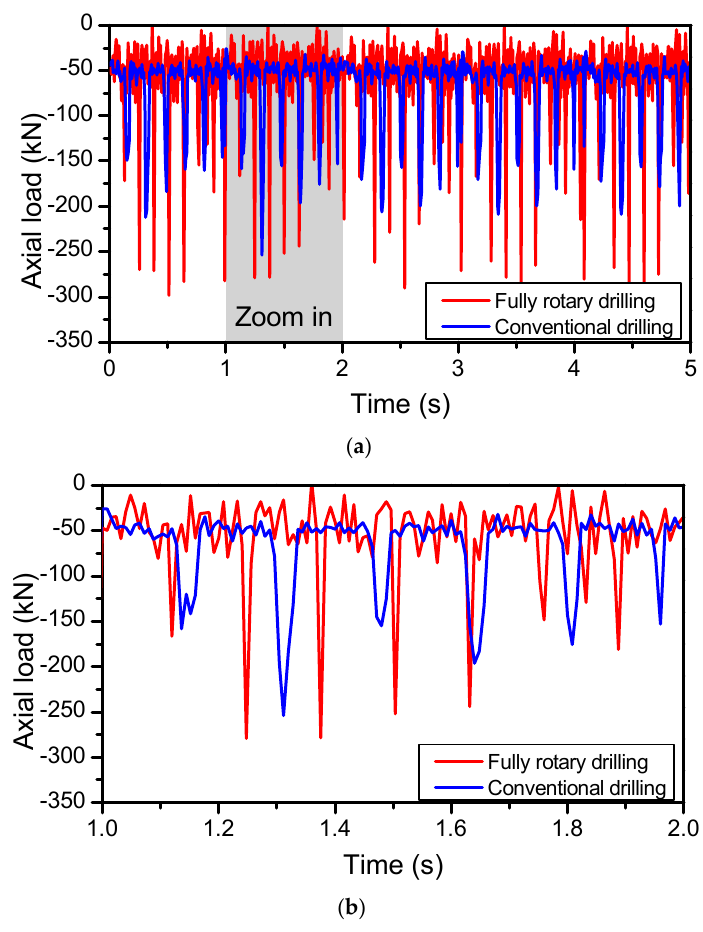
Figure 7. Axial loading versus time on drill-string for both fully rotary and conventional drilling: ( a ) axial loading versus time at 0–5 s and ( b ) axial loading versus time at 1.0–2.0 s.